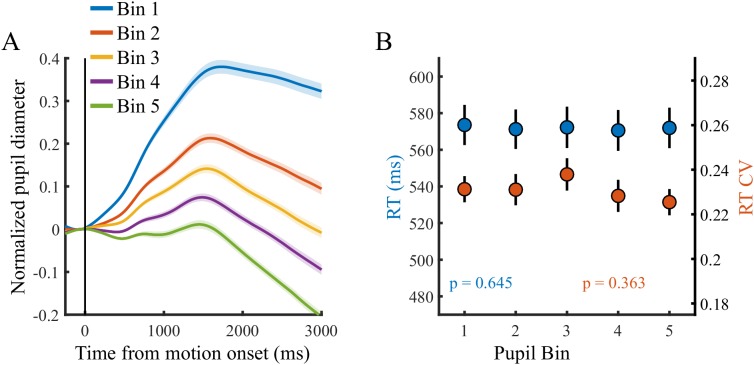
The relationship between baseline pupil diameter and task performance, for band-pass (0.1–6 Hz), rather than low-pass (<6 Hz) filtered pupil diameter data.(A) Pupil time-course for the five bins. (B) Behavioural performance for the five bins. Markers indicate mean reaction times (RT, blue, left y-axis) and reaction time coefficient of variation (RTcv, red, right y-axis). Error bars and shaded regions denote ±1 standard error of the mean (SEM). Stats, linear mixed effects model analyses (Statistical analyses).